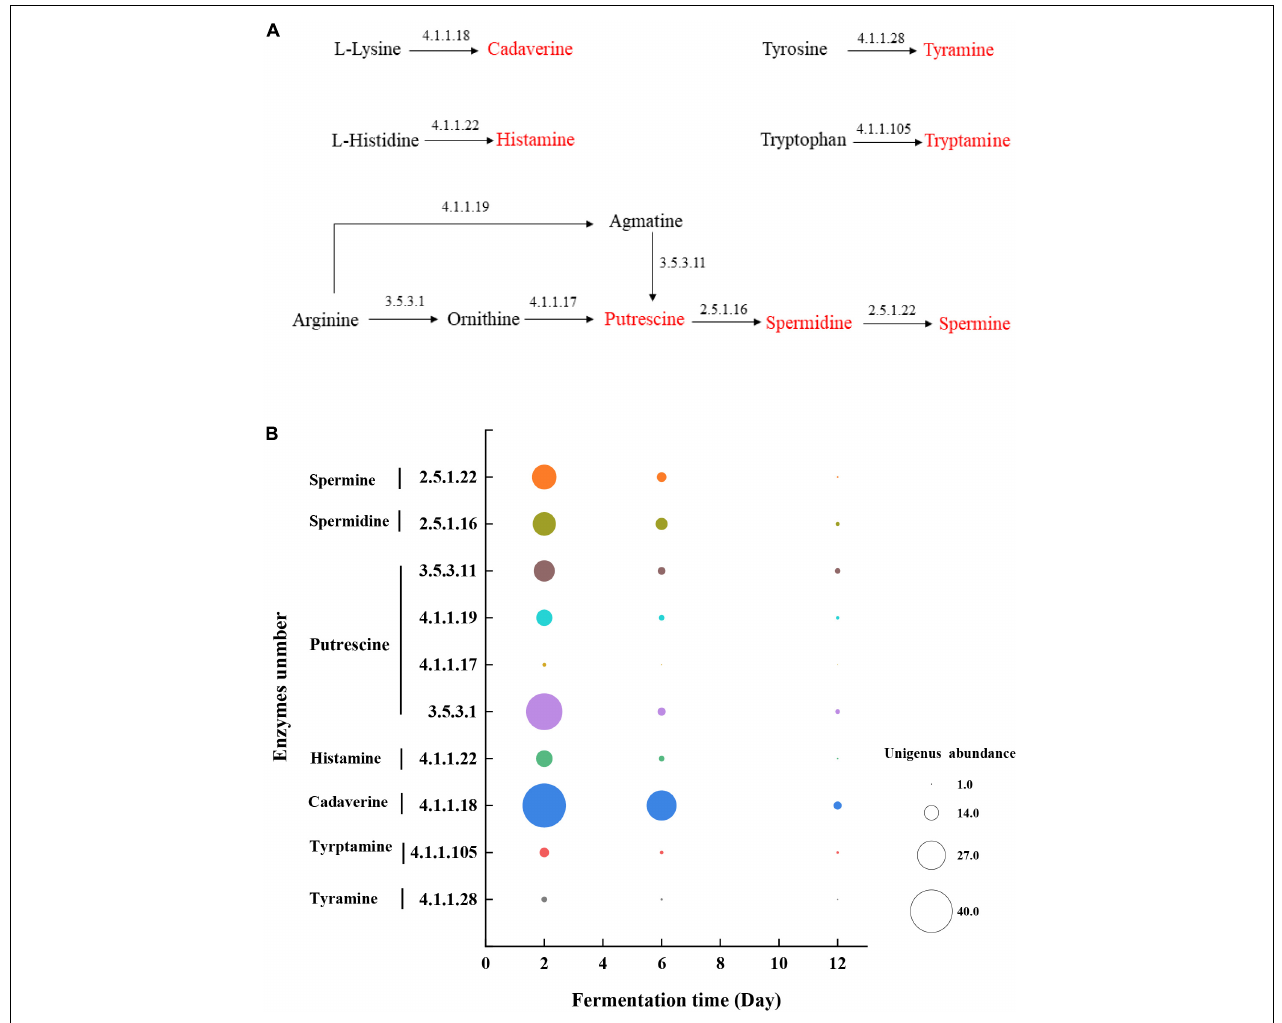
FIGURE 5 | (A) Pathway of production of BAs and (B) the unigene abundance of the annotated enzymes in microbial community during mustard